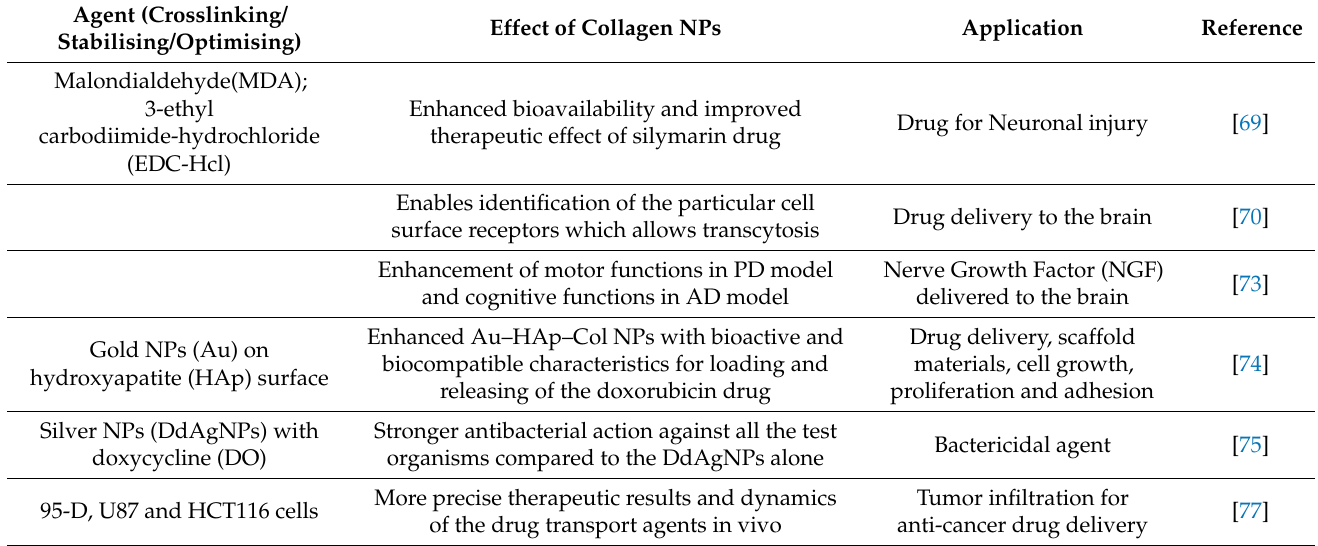
Table 2. Investigations on collagen NPs in